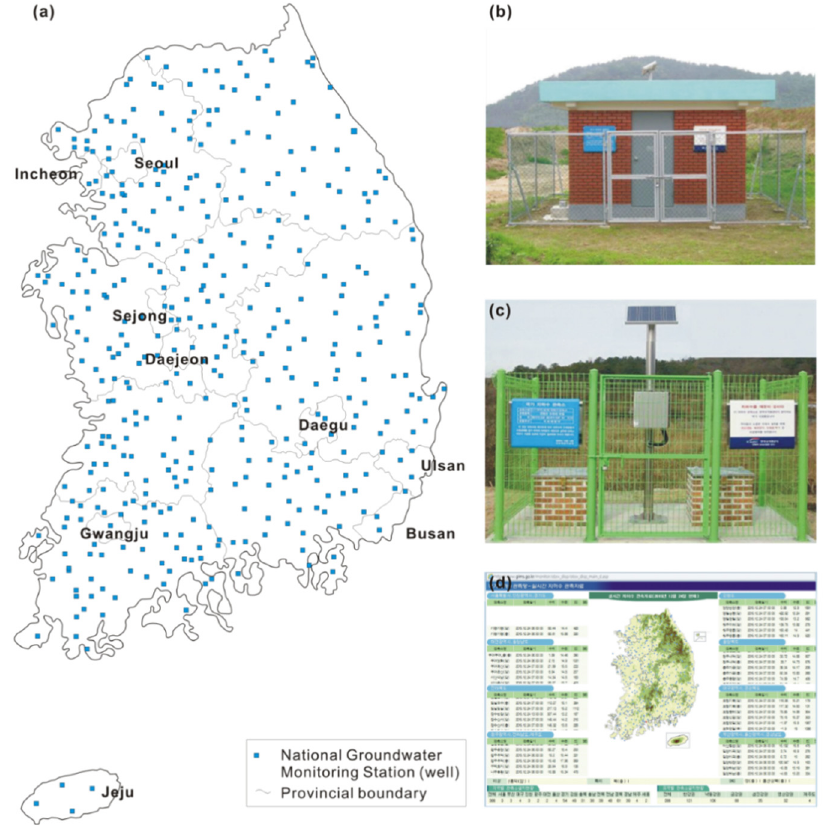
Figure 3. Distribution of the National Groundwater Monitoring Stations (wells). ( a ) scenes of the stations; ( b ) scenes with cover house and ( c ) scenes without cover house; and ( d ) webpage screenshot (www.gims.go.kr) showing the operational status of all stations and the real time monitoring data.